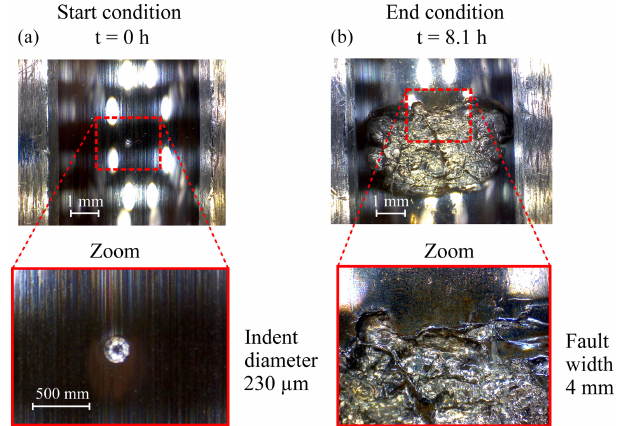
Figure 1. The drive train setup used to reduce the lifetime of a bearing to less than 1d, allowing for the generation of vibration data during the accumulation of an operational bearing fault.